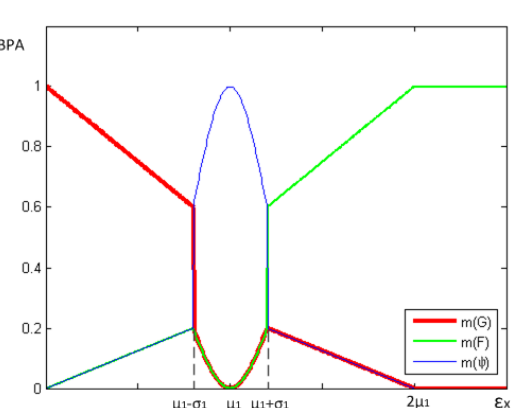
Figure 2. The BPA